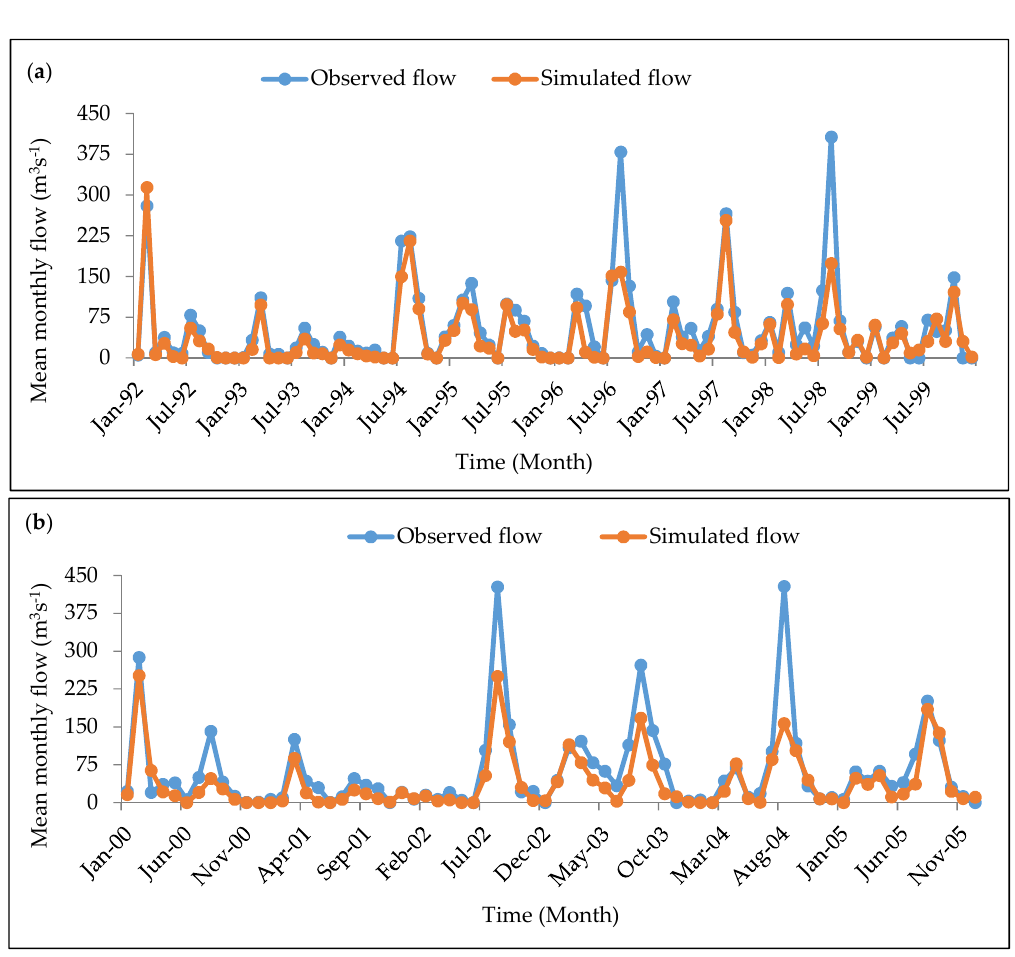
Figure 7. Soil and Water Assessment Tool (SWAT) model calibration ( a ) and validation ( b ) for streamflow at the monthly time scale during 1992–1999 and 2000–2005, respectively.